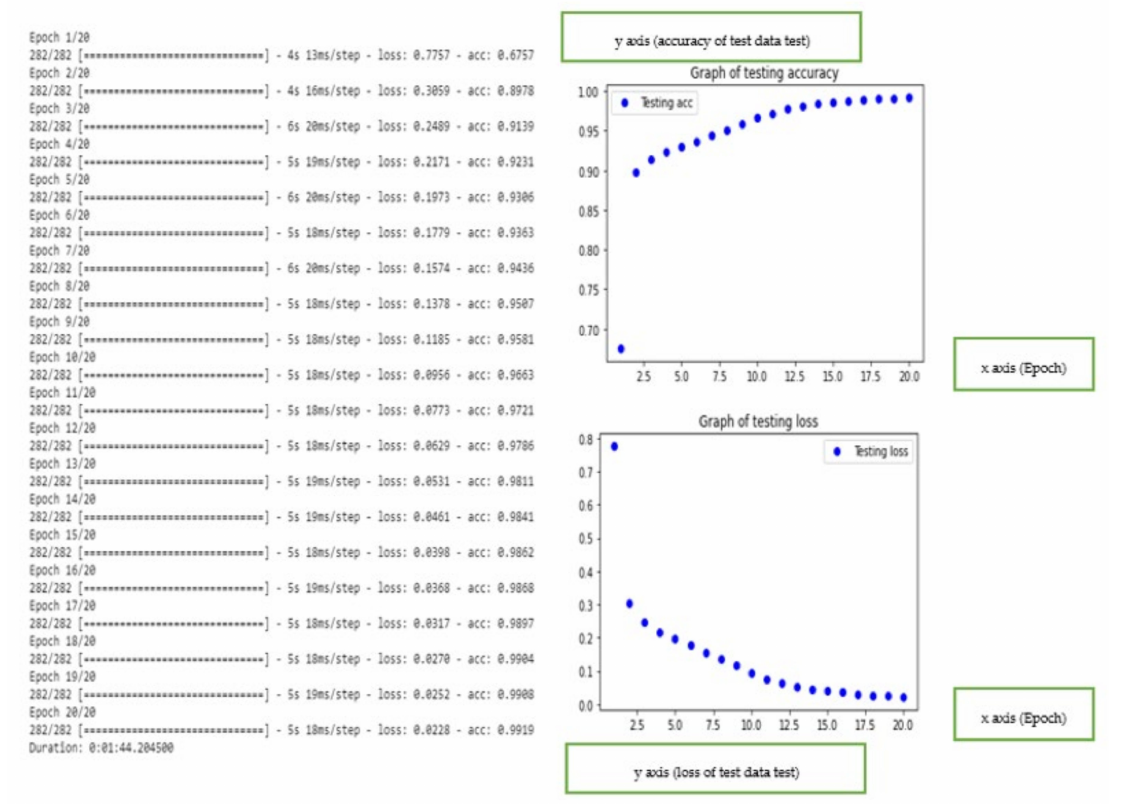
Figure 6. Details of accuracy and loss values in program testing, graph of testing accuracy and graph of testing loss (one example of the test results of the File 22 program with program details as shown in Table